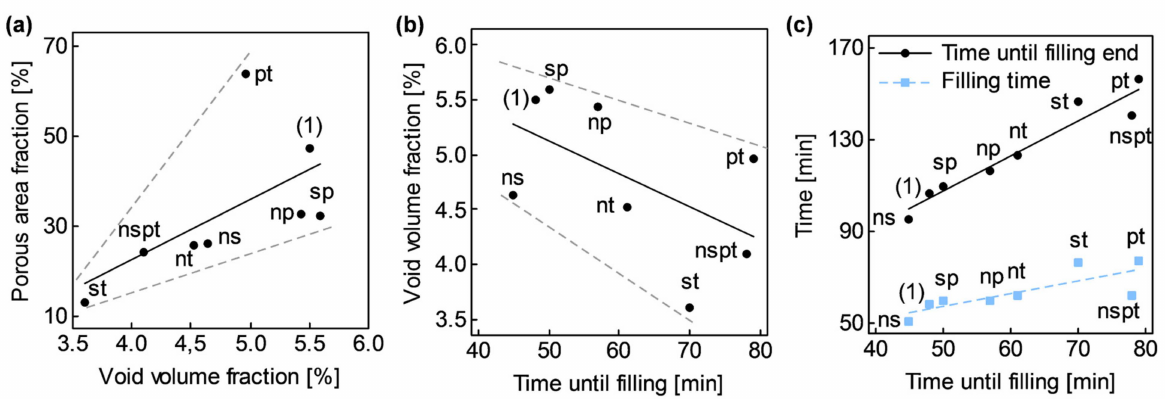
Figure 13. Noteworthy dependencies between response variables and covariates: ( a ) Porous area fraction, s 0 , vs. void volume fraction, v (cid:48) ; ( b ) Time until filling, t 0 → fill ; ( c ) Time until filling end, t 0 → fill , and filling time, t fill . 0 0 end The described statistical procedure was applied to the experimental data gathered in Figure 14. In Figure 15a,b, it can be seen how main factor effects l N , l S , and l P behaved similarly with both response variables; while l T was considerably larger in case of v (cid:48) , which 0 could have been caused by the correlation found between v (cid:48) and t 0 → fill , and the coupling 0 0 between T and t 0 → fill . Furthermore, the NS interaction in case of s 0 (Figure 15a) stood out 0 from the other two-factor interactions. Factors N, S, and T at high level ( + ) appeared to enhance void minimization, while factor P negatively affected specimen porosity.